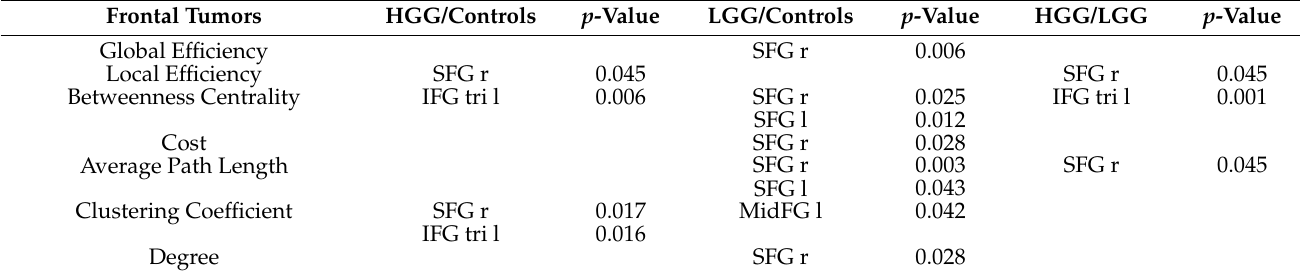
Table 1. Graph-theory statistics results for gliomas involving the frontal lobe. Significance is reported as FDR corrected p